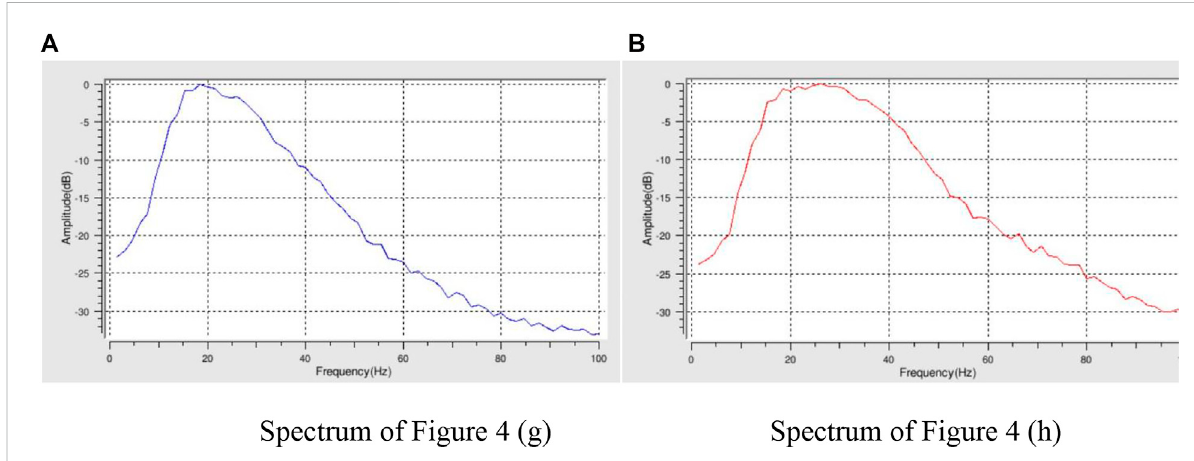
FIGURE 5 Spectrum of LSRTM. (A) spectrum of Figure 4 (g) . (B) spectrum of Figure 4